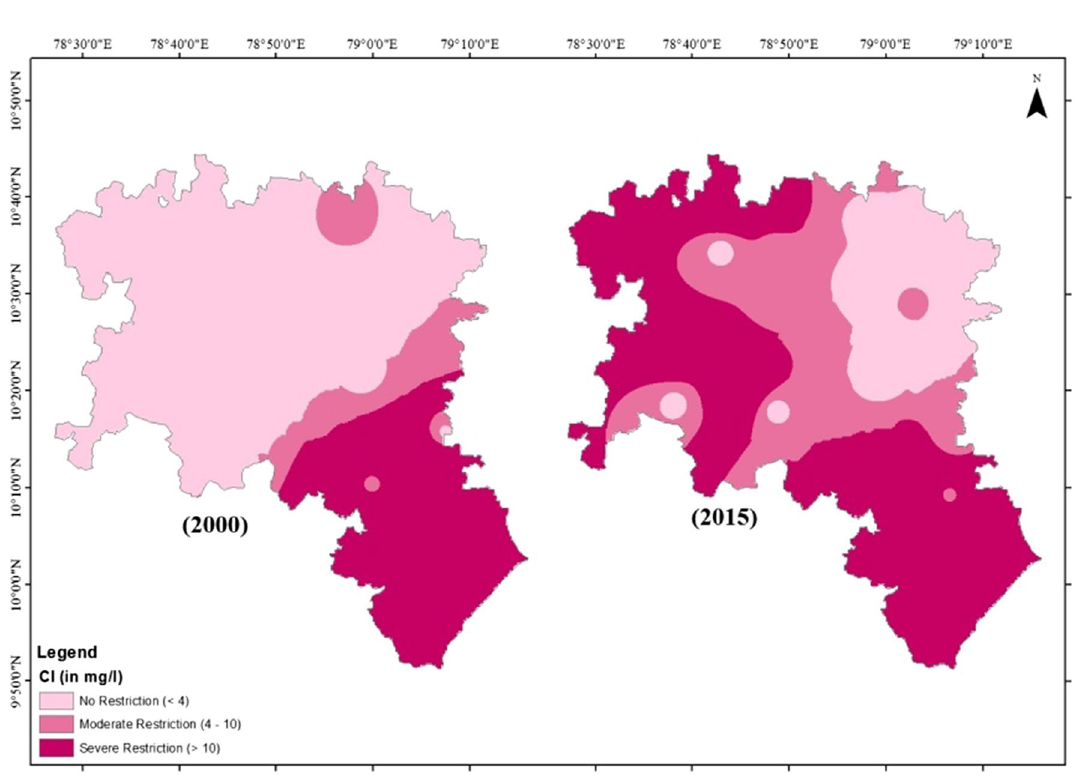
Fig. 7 Spatial distribution of chlorine (2000 and